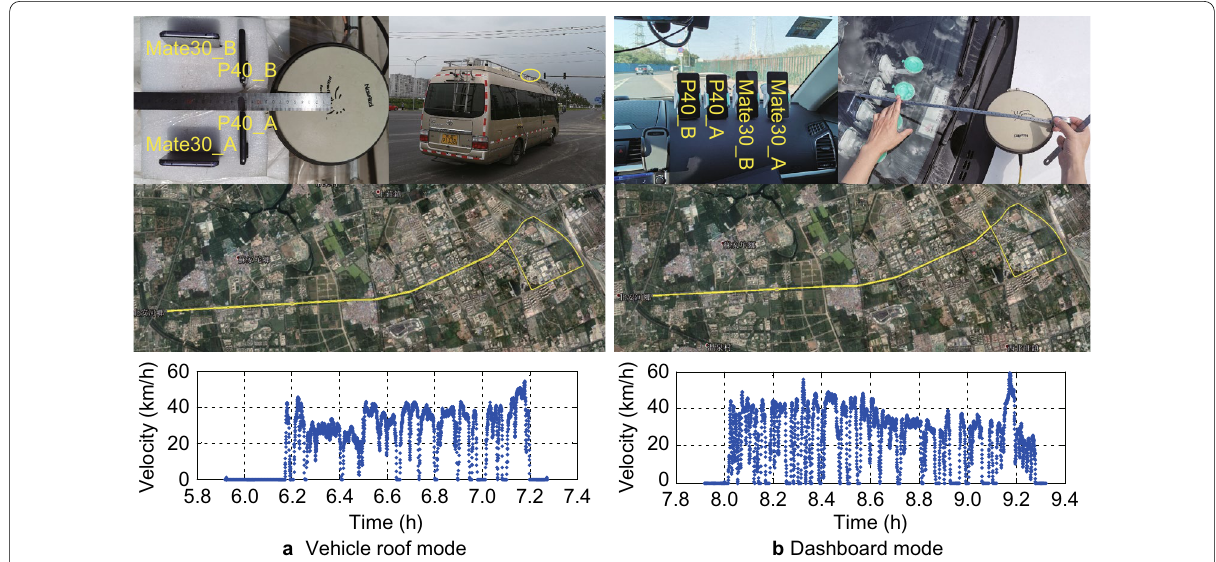
Fig. 1 The experimental setups, driving routes, and vehicle speed information for the kinematic tests in the a vehicle-roof mode and b dashboard mode